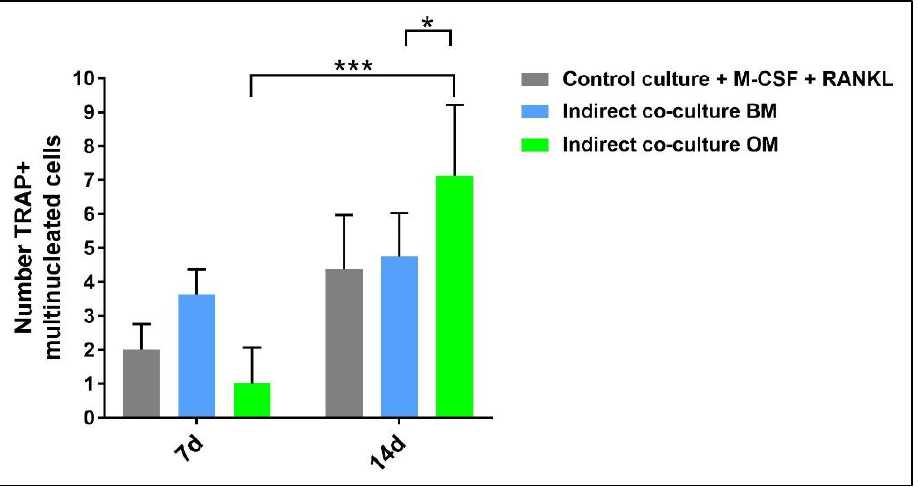
Figure 12. Diagram of the number of PBMCs positive for tartrate-resistant acid phosphatase derived from the indirect co-culture in basal medium (BM) or osteogenic medium (OM) at 7 days and 14 days compared to the control sample (CTRL + M-CSF + RANKL) (* p - value ≤ 0.05, *** p ≤ 0.001). Moreover, actin filaments were quantified by image analysis using the NIS-Element imaging software Advanced Research (Figure 13). The threshold for the detection of the signal was set up at 38 – 255 with Clean 1× (Applications → Cell Counting). The analysis was performed by light microscopy on three fields at 10× magnification. Figure 13. Diagram representing the percentage of area positively stained for actin filaments of PBMCs in both the single-cultures (control culture) and in indirect co-cultures exposed to basal me- dium (BM) or osteogenic medium (OM) for 7 and 14 days. 3.5. Material Testing with the Indirect Co-Culture Before starting the indirect co-culture with the material, some considerations have to be done. In our case the material was prepared completely under sterile conditions. Otherwise, the material may be sterilized by immersion for at least 30 min up to 2 h in EtOH 70% or by UV-irradiation, depending on the composition of the material and the consequent reactivity to the sterilization method. Once performed this first step, material pre-wetting has to be accomplished as a pre-requisite for cell attachment: (a) The material is dipped in complete culture medium for OBs or PBMCs: the presence of FBS in the medium, whatever it is, is needed for the adsorption of serum proteins to the material (b) Incubate at 37 °C overnight